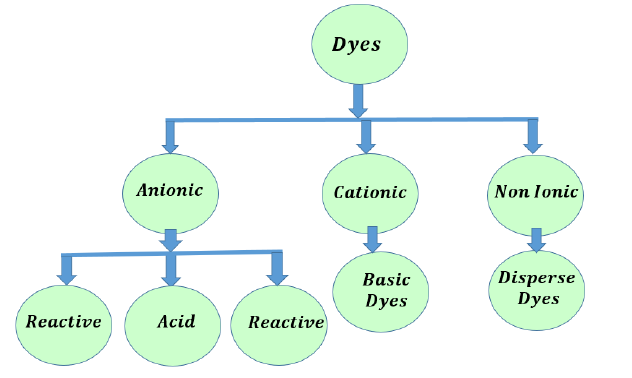
Fig. 2. Classification of dyes